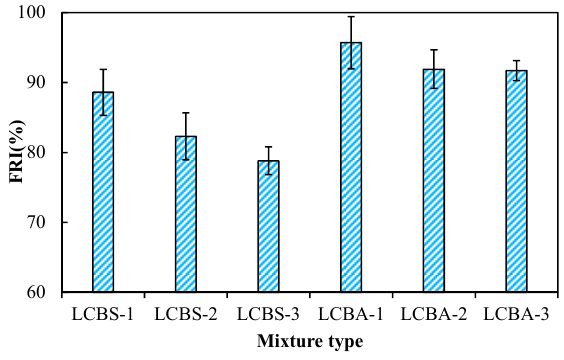
Figure 7. FRI of the stabilized mixture after curing for 28 days.